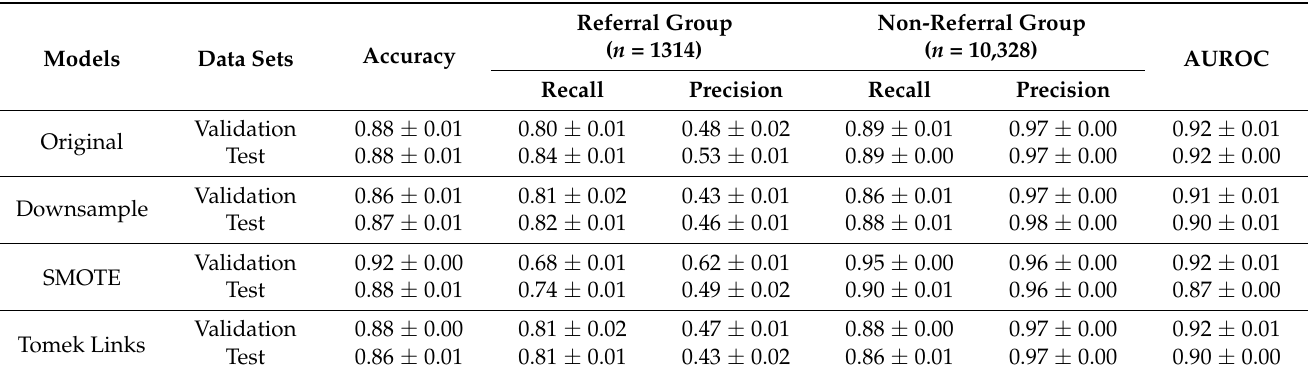
Table A1. Performance metrics of pilot experiment for the original and other three methods to deal with the imbalance of data.